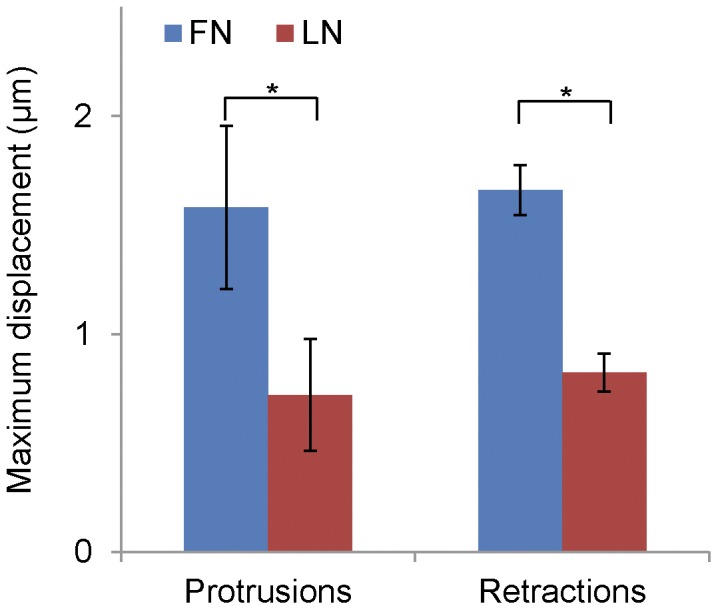
Bead displacements for CHO.B2 cells migrating on FN or LN.Cells were plated onto bead embedded polyacrylamide substrates (E = 1 kPa) coated with adhesive ligand. The relative bead displacements were measured in regions of protrusion, retraction and the cell body. Maximum deformation was measured in gel sub-regions (see Methods) by interpolating bead displacements onto a regular grid during events of protrusion and retraction. Independent protrusion and retraction events show no significant difference (P = 0.61 and P = 0.18, for FN and LN respectively, in a cell paired t-test), indicating that in each case we measured the maximum deformation of the gel. Cells plated on FN-coated gels deform them significantly more than LN-coated gels (P = 0.028 and P = 0.016 for protrusion and retractions respectively), suggesting that they exert stronger forces. Data are expressed as the mean ± SEM (n = 13 cells).